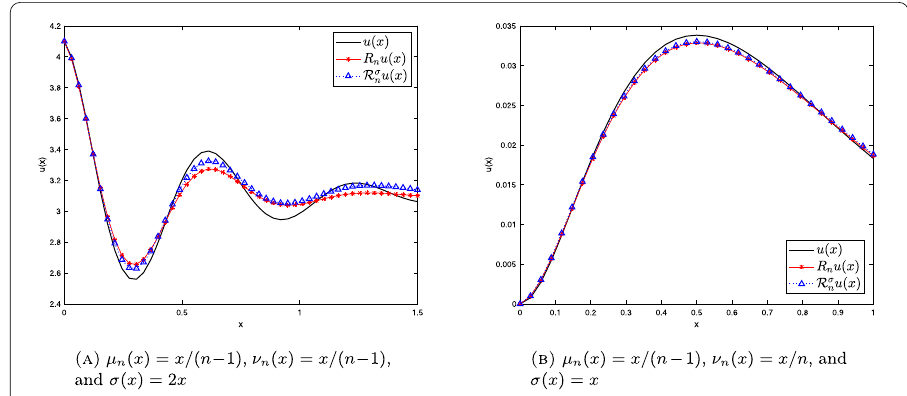
Figure 1 Test function (black line), standard Baskakov operator (red-star), and newly constructed Baskakov operator (blue-upward pointing triangle) with the given parameters on equally spaced